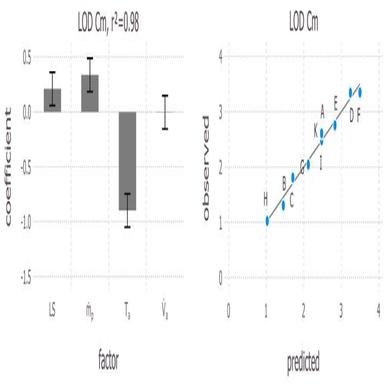
Coefficient plot (left) and observed vs. predicted plot (right) of LODm.